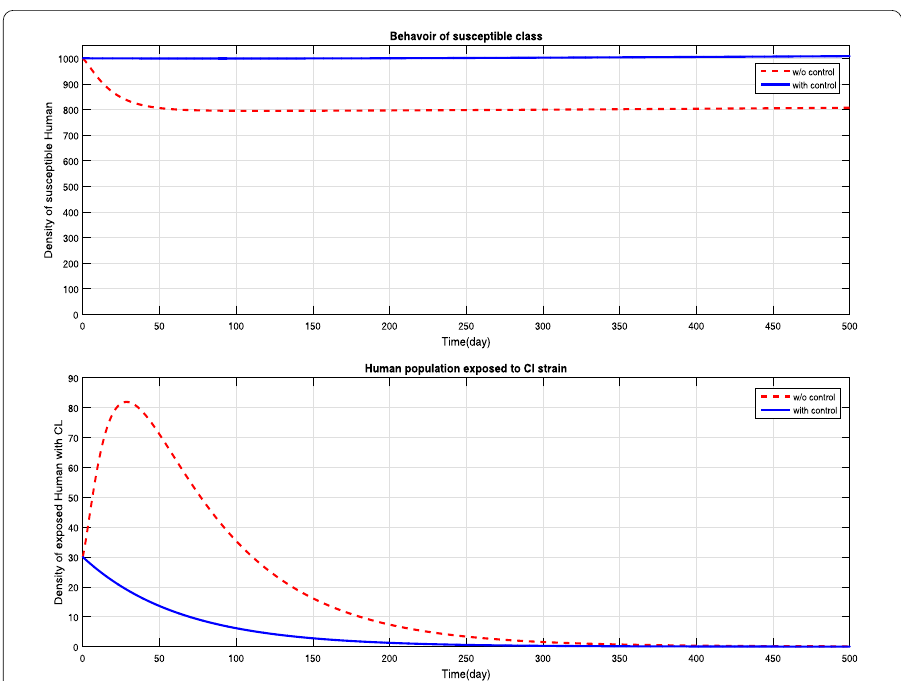
Figure 2 Comparison of behaviors with and without control in case of S h and E 1